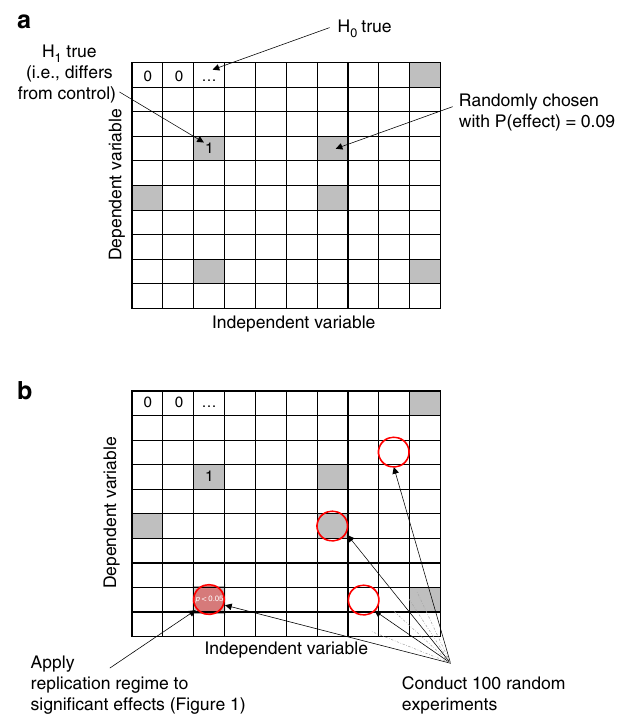
Fig. 3 Illustration of the ground truth in discovery-oriented simulations. a Landscape of true effects for discovery-oriented research. Each cell is randomly initialized to 0 (i.e., H 0 is true) or 1 (i.e., H 1 ) with probability .09, re fl ecting the estimated baserate of true effects in psychology 4 . The landscape is initialized anew for each of the 1000 replications in each simulation experiment. b For each replication, 100 discovery-oriented experiments are conducted, each with a randomly chosen dependent and independent variable (sampling is with replacement). When an experiment yields a signi fi cant result ( p < : 05, two-tailed single-sample t -test or BF 10 > 3, Bayesian single-sample t -test), the appropriate replication regime from Fig. 1 is